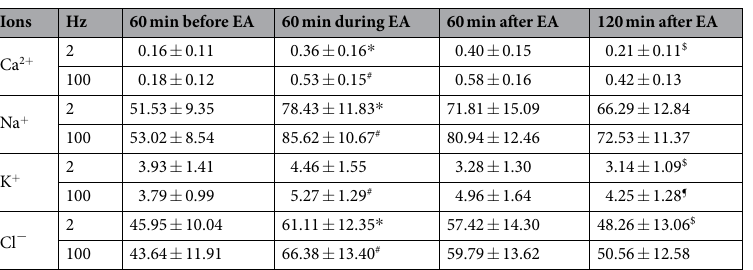
Table 2. The effect of EA at 2 and 100 Hz on the extracellular ion levels (mmol/L). * 60 min during 2 Hz EA vs 60 min before 2 Hz EA, p < 0.05; $ 120 min after 2 Hz EA vs 60 min during 2 Hz EA, p < 0.05; # 60 min after 100 Hz EA vs 60 min during 100 Hz EA, p < 0.05; ¶ 120 min after 100 Hz EA vs 60 min during 100 Hz EA, p < 0.05; Two- way ANOVA followed by Duncan post hoc